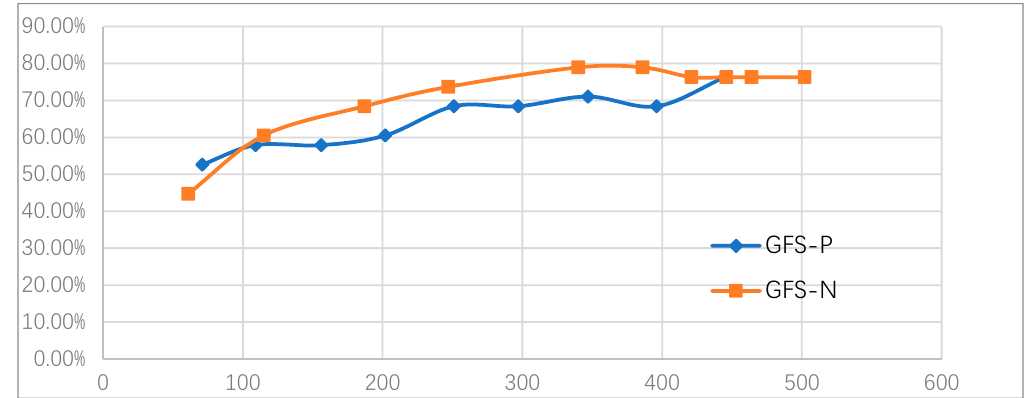
Figure 9. The precision of the two methods at different feature points.